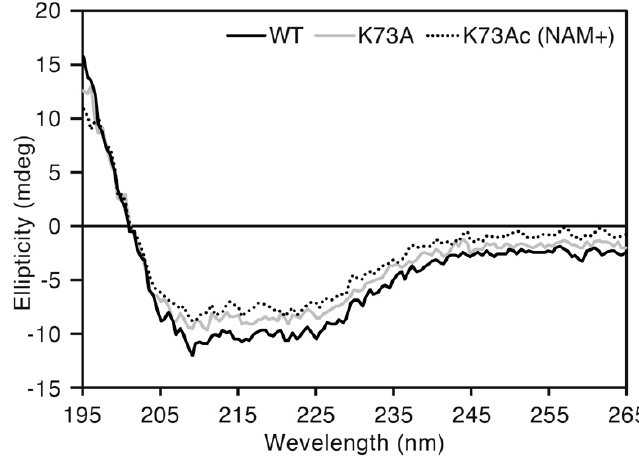
Figure 4. Circular dichroism (CD) spectral analysis. The black, gray, and dotted lines indicate AlaRS WT, K73A, and K73Ac (NAM+), respectively. Scanning was performed three times for each sample and the average was plotted.